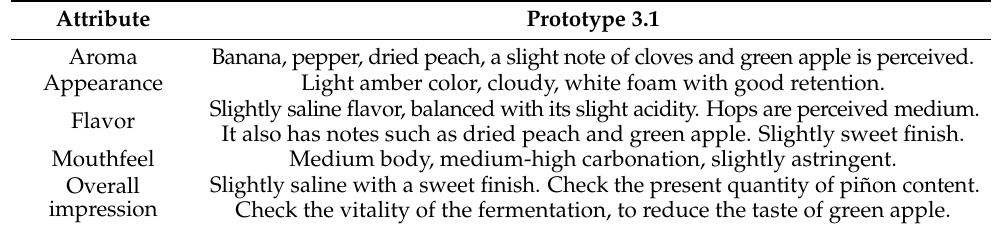
Table 7. Sensory analysis of the best evaluated prototype.